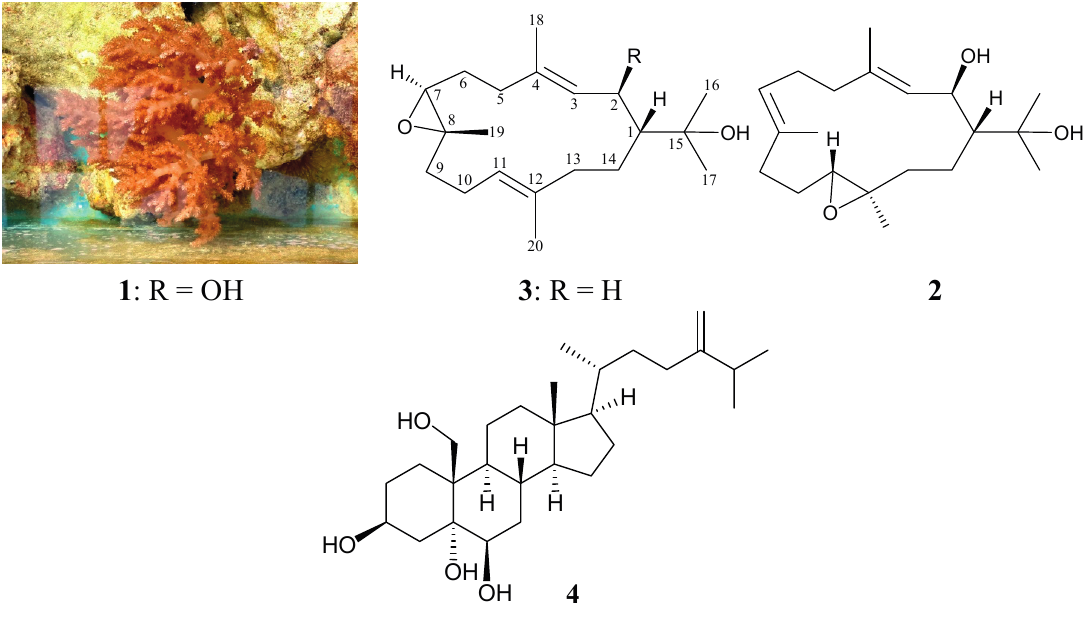
Figure 1. The soft coral Nephthea columnaris and the structures of 2 β -hydroxy-7 β ,8 α - epoxynephthenol ( 1 ), 2 β -hydroxy-11 α ,12 β -epoxynephthenol ( 2 ), epoxynephthenol ( 3 ) and nephalsterol A ( 4